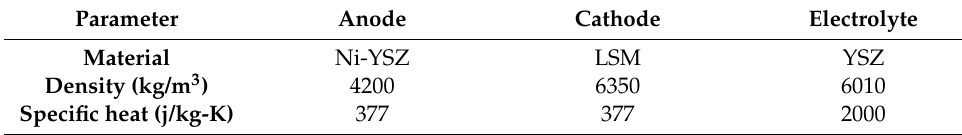
Table 2. Cell components’ material